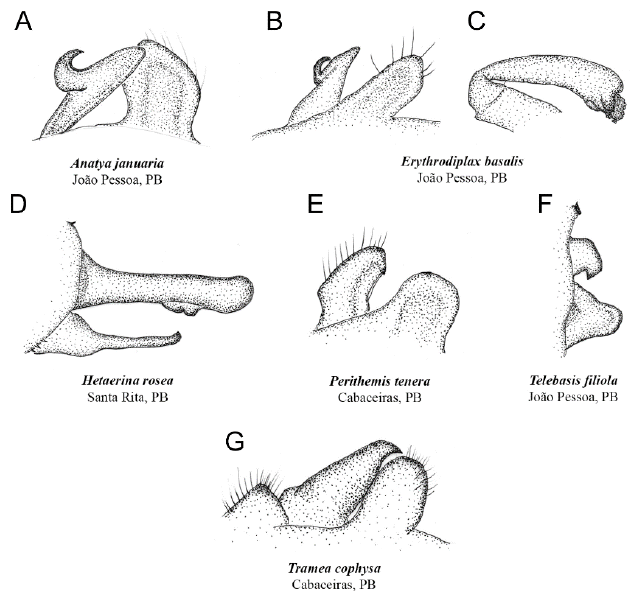
Figure 5. Morphology of male Odonata adults collected in Paraíba state, Brazil (lateral view of): ( A ) secondary genitalia of Anatya januaria ; ( B ) secondary genitalia and ( C ) vesica spermalis of Erythrodiplax basalis ; ( D ) caudal appendages of Hetaerina rosea ; ( E ) secondary genitalia of Perithemis tenera ; ( F ) caudal appendages of Telebasis filiola ; ( G ) secondary genitalia of Tramea cophysa . In turn, the E. carmelita we analyzed was 98.67% similar to a sequence identified as